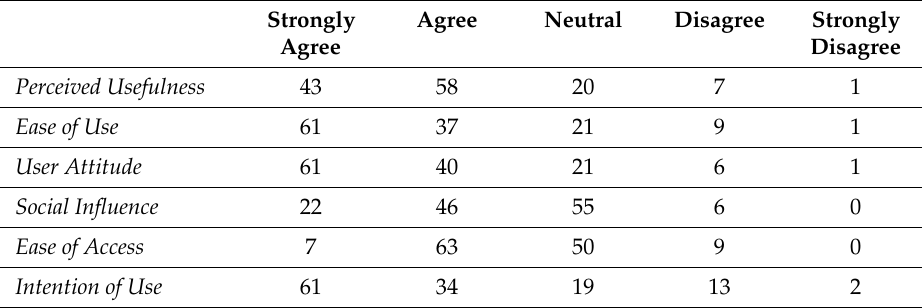
Table 4. Results obtained from an opinion survey after testing the LoT@UNED platform (counting with a five-point